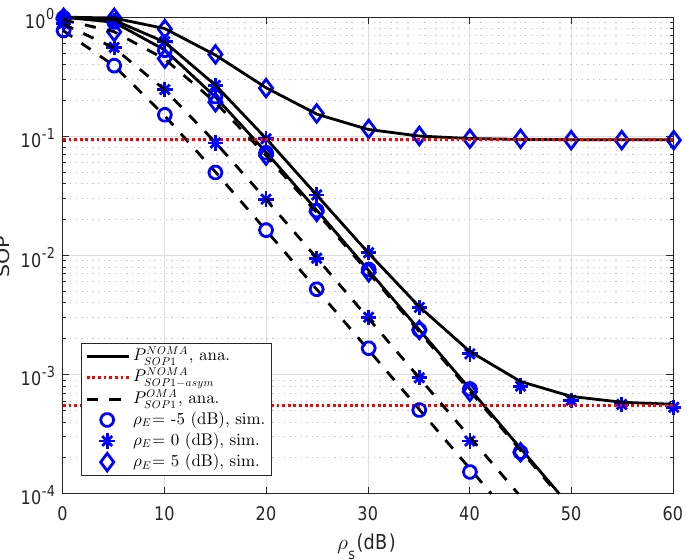
Figure 6. Comparison study of SOP for NOMA and OMA for User D1 versus ρ S = ρ R as varying ρ E .